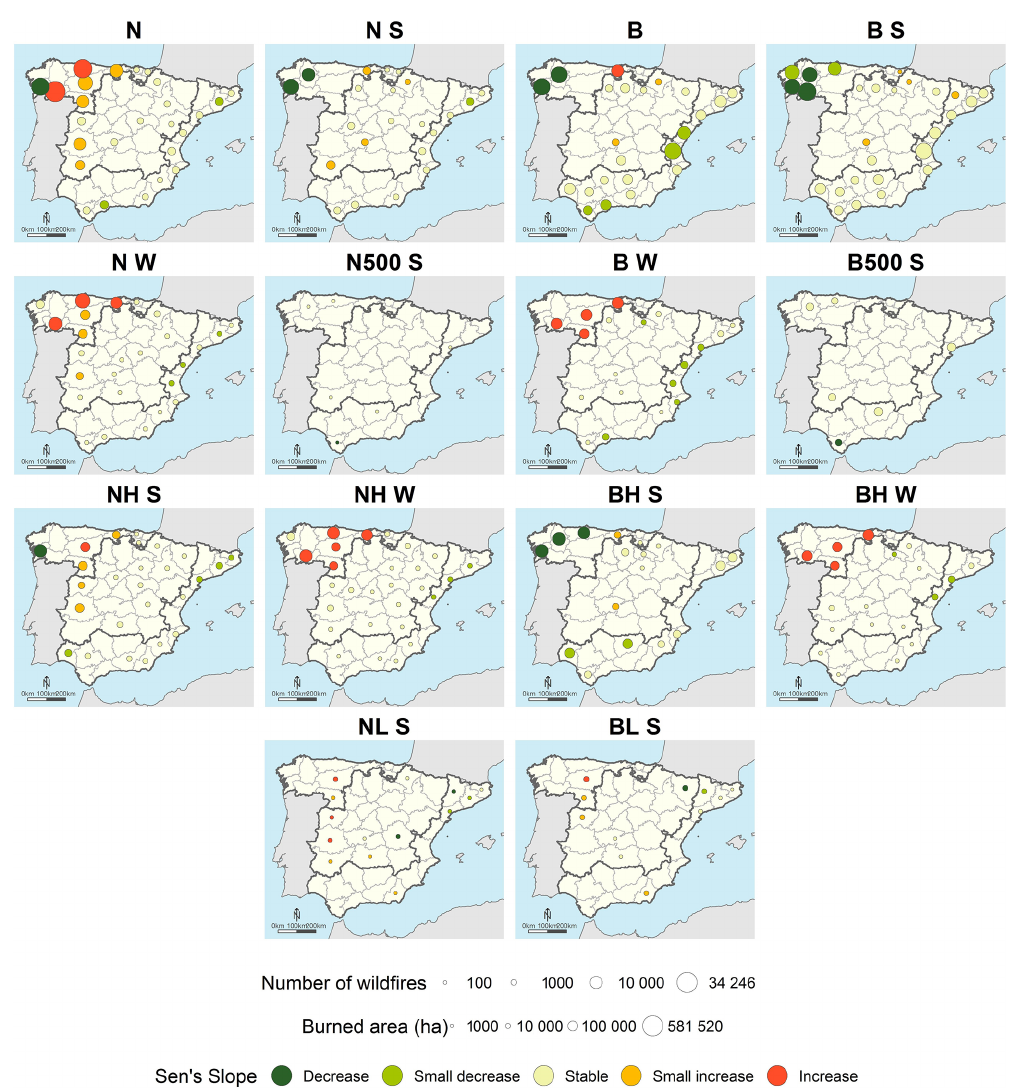
Figure 4. Spatial distribution of selected significant Sen’s slope (SS) values from 1974 to -2013 according to Mann–Kendall. SS classes are based on the following intervals: decrease ( < − 1.6), small decrease ( − 1.6; − 0.5), stable ( − 0.5; 0.5), small increase (0.5; 1.6) and increase ( > 1 . 6). Proportional symbols represent the number of wildfires and burned area value. SS value is displayed in colour using standard deviation intervals. Provinces without symbols represent non-significant trends according Mann–Kendall test. See Sect. 2.1 for acronyms and description of fire